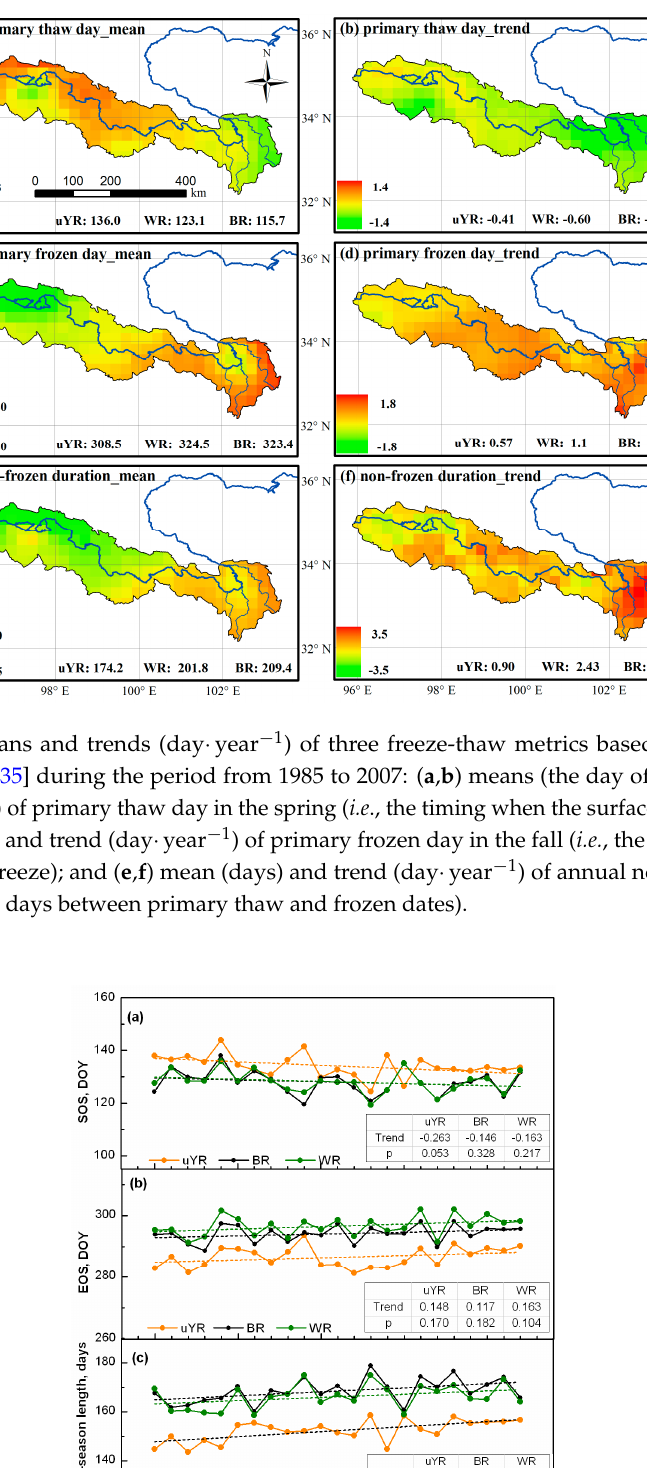
Figure 5. The trends in three phenological metrics derived from the GIMMS3g NDVI dataset during the period from 1985 to 2007 in the TP study areas, including, ( a ) start of growing-season (SOS, in day of year, DOY); ( b ) end of growing-season (EOS, in DOY) and ( c ) annual growing-season length (in days).